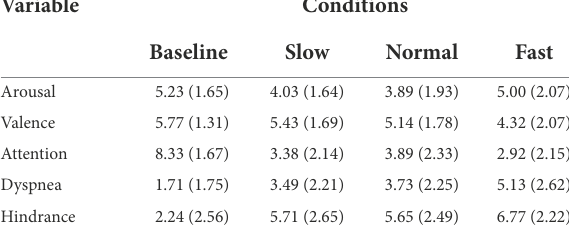
TABLE 2 Ratings of perceived emotion, attention, dyspnea, and hindrance for all participants across each breathing condition.